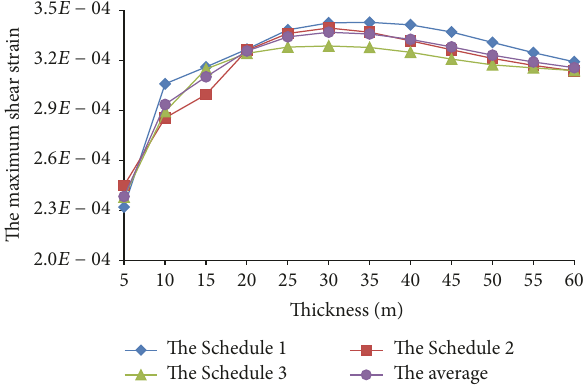
Figure 5: The distribution of the maximum shear strains.